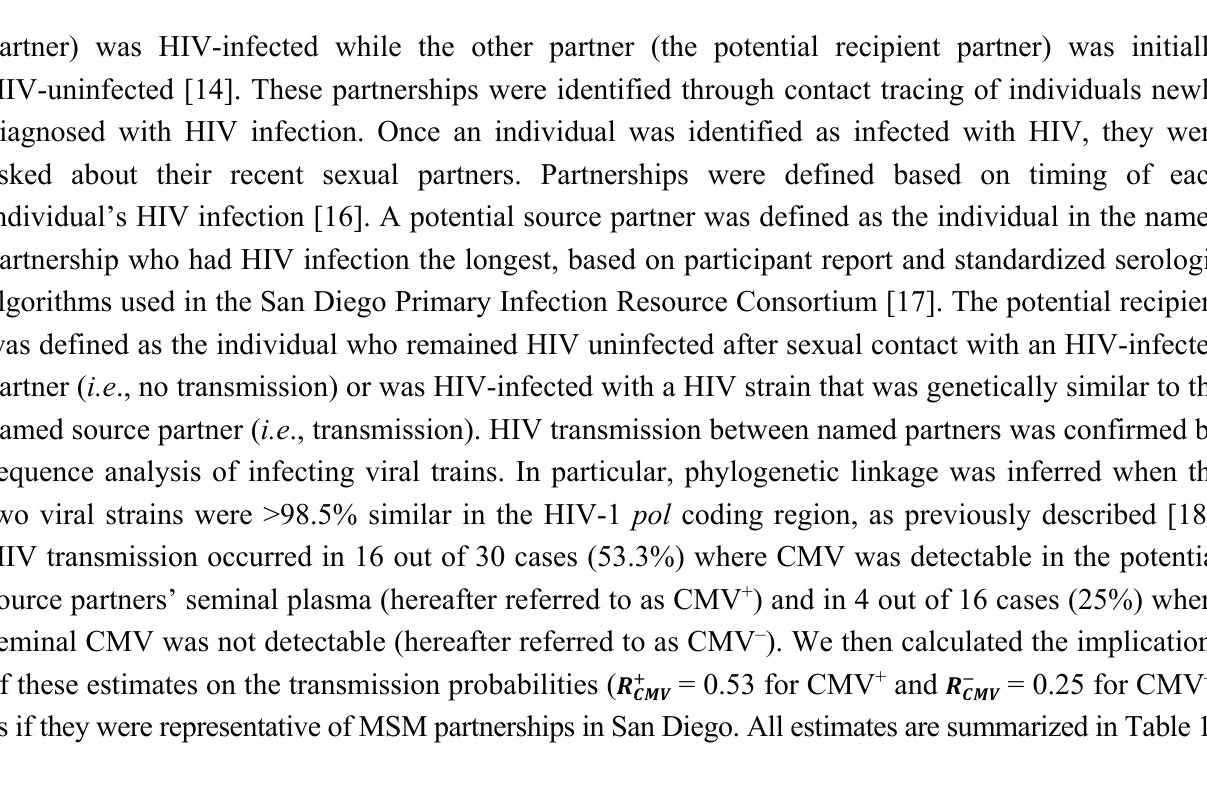
Table 1. Summary of associations between CMV shedding and other factors to HIV transmission among MSM in San